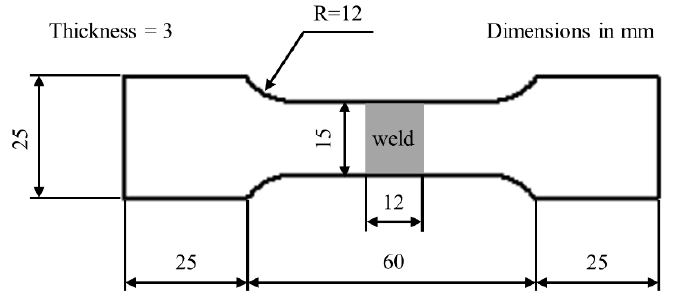
Figure 2. Tensile test specimen dimensions .